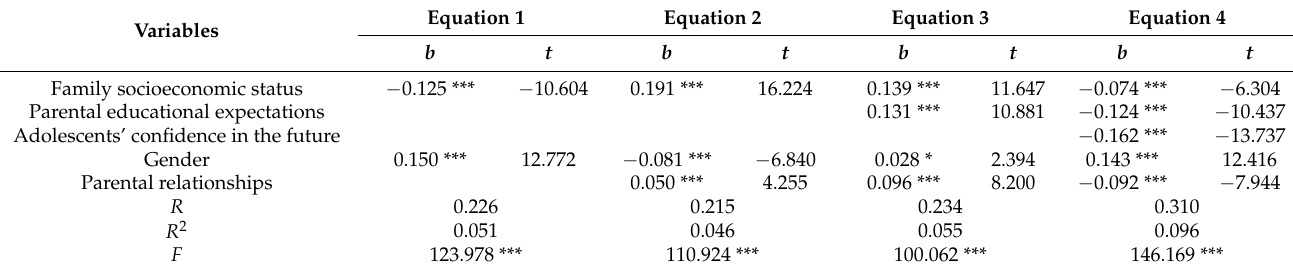
Table 2. Regression